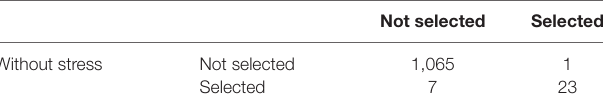
TABLE 10 | Confusion matrix of coincidence between selected 30 singular value vectors selected among all 1,096 singular value vectors, u samples without stress and 24 singular value vectors selected among all 1,096 singular value vectors, v attributed to samples with stress. ℓ k